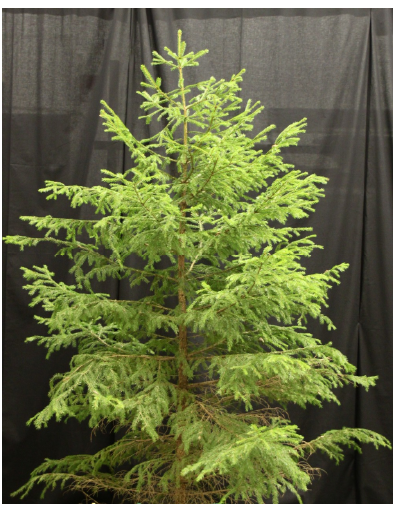
Fig. 3. The Norway spruce.